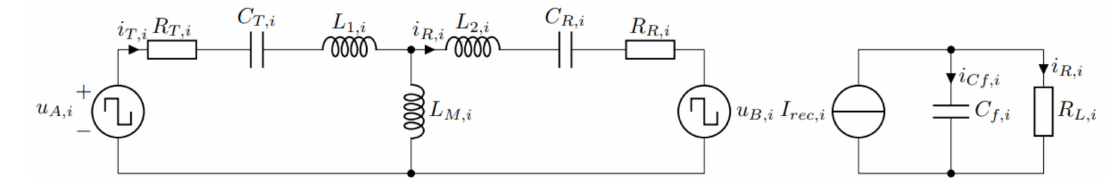
Figure 5. Simplified resonant circuit using the equivalent T